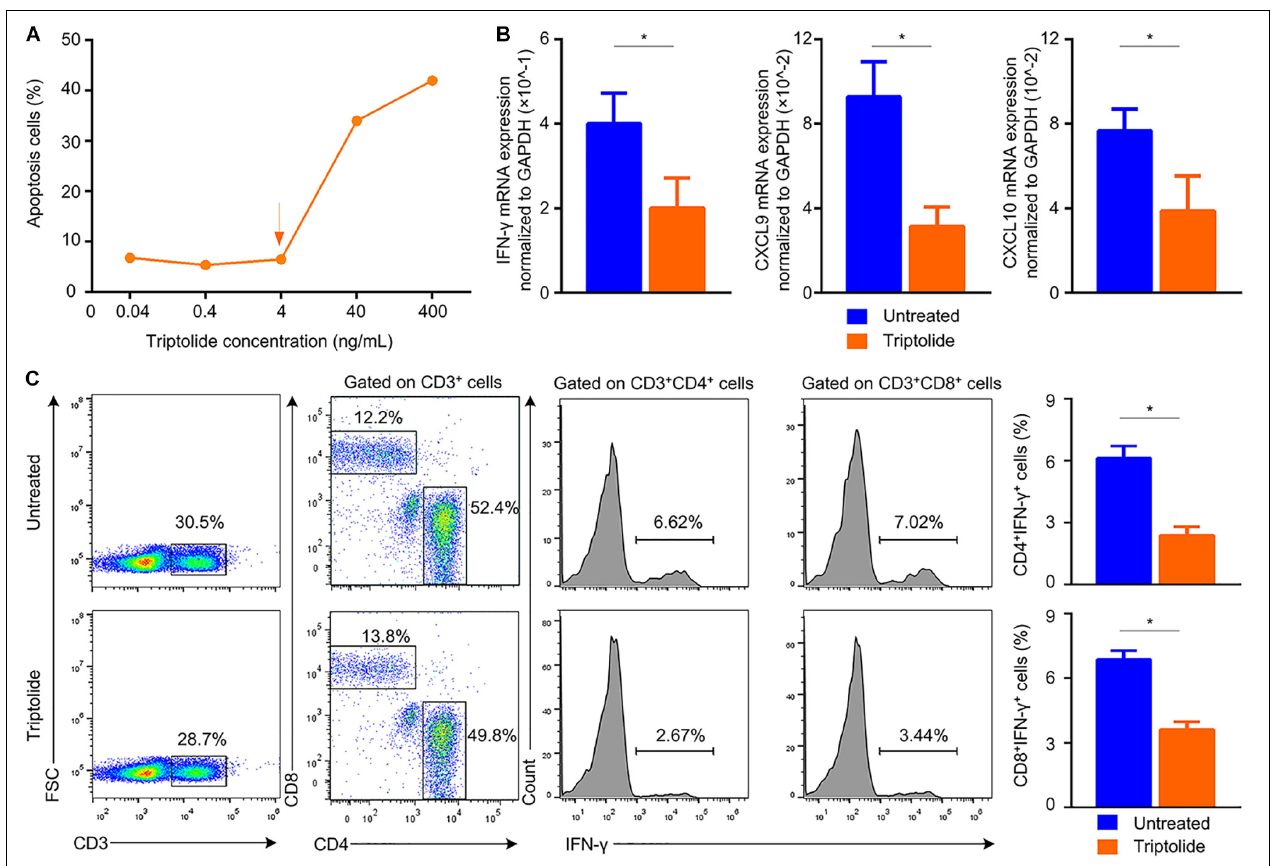
FIGURE 5 | Triptolide reduces the mRNA expression of IFN- γ and IFN- γ –inducing factors, and also inhibits the frequency of IFN- γ –producing T lymphocytes in vitro . (A) Apoptotic cells were detected by flow cytometry. Mononuclear cells from the recipient spleens were incubated with various concentrations of triptolide (0.04, 0.4, 4, 40, and 400 ng/mL) for 72 h. To evaluate the effect of triptolide on IFN- γ -producing T cells in vitro , mononuclear cells from recipient spleens were stimulated with anti-CD3 plus anti-CD28 with or without tiptolide (4 ng/mL) at 37 ◦ C for 24 h. The mRNA expression of IFN- γ , CXCL 9, and CXCL10 was assessed by RT-PCR (B) . (C) Representative dot plots for frequencies and counts of IFN- γ –producing T cells in culture media were shown. Data were represented as mean ± SD of at least three independent samples. * p < 0.05; Student’s t